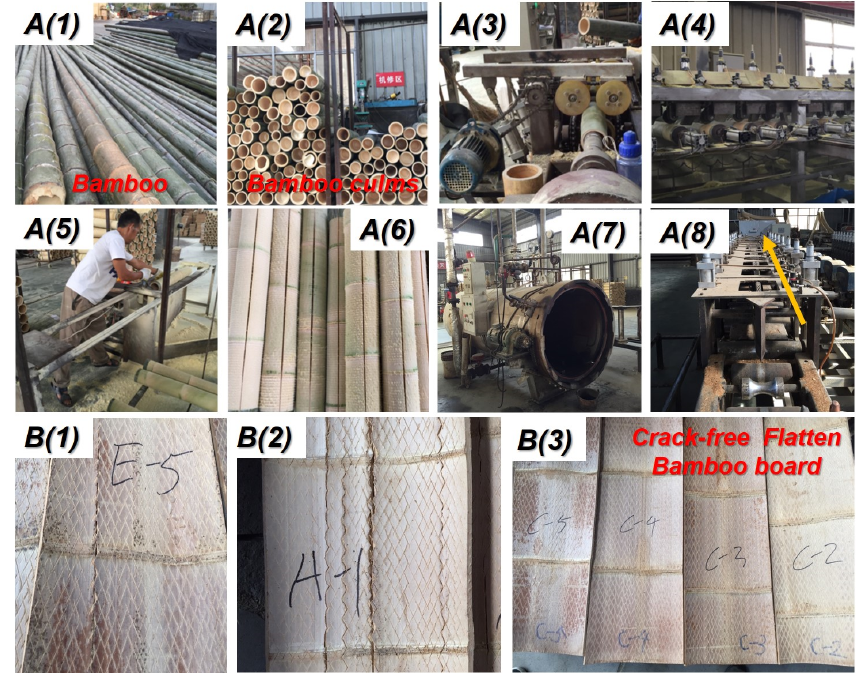
Figure 2. Manufacturing process of crack-free, flattened bamboo board: A(1) bamboo; A(2) bamboo culms; A(3) remove yellow bamboo and inner nodes machine; A(4) remove green bamboo machine; A(5) splitting bamboo culms; A(6) the bamboo culms after splitting process; A(7) saturated steam heat treatment device; A(8) bamboo flattening machine; B(1,2) flatten bamboo board with obvious cracks; B(3) obtained successful crack-free flatten bamboo board through longitudinal flattening